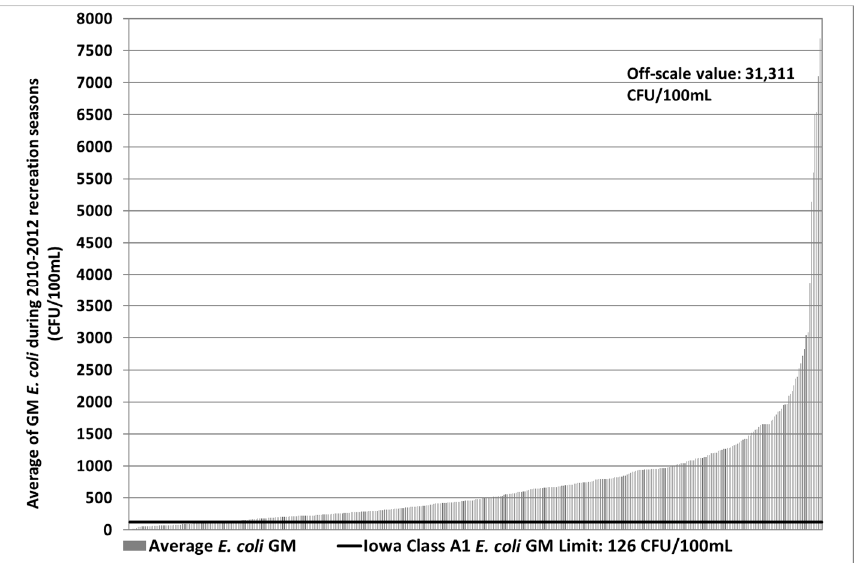
Figure 1. Summary of average recreation season geometric means (GM) of E. coli at Iowa warmwater stream/river monitoring stations for 2010–2012 (N = 395). Bars on the x-axis represent individual sites.